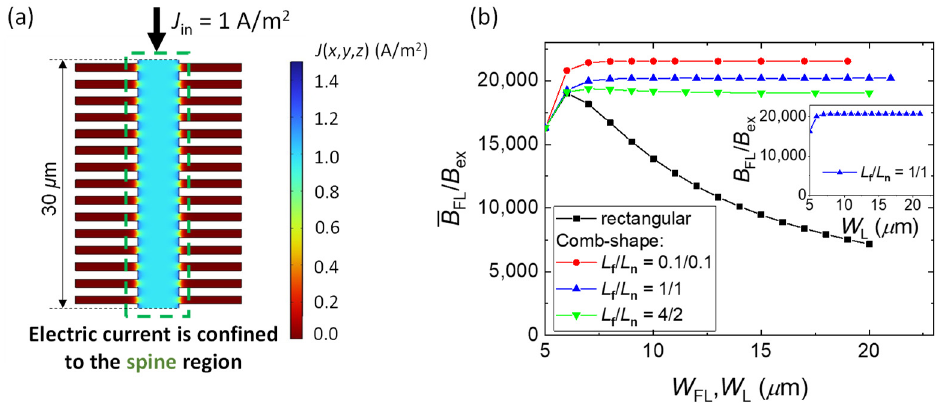
Figure 6. ( a ) Distribution of the electric current density ( J ) in a comb-shaped FL. The notches confine the electric current within the spin region. ( b ) B ̅ FL / B ex for the comb-shaped FL for different L f / L n combinations of 0.1/0.1, 1/1, and 4/2 (in μ m). The inset shows B FL / B ex vs. W L of the comb-shaped FL with L f = L n = 1 μ m. B ̅ FL / B ex of the rectangular FL also plotted for comparison. In the comb-shaped FLs, the MFC–FL overlap does not cause a reduction in B ̅ FL / B ex . Larger B ̅ FL / B ex can be achieved with a finer comb-shaped FL (i.e., with a smaller L f and L n ).